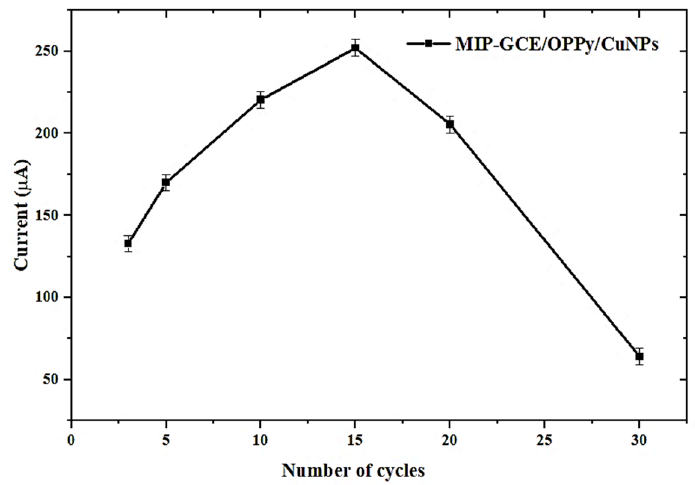
Figure 8. Effect of the number of electropolymerization cycles on the DPV peak current of sulfadiazine. Measuring conditions: 10 − 6 mol L − 1 SDZ in 0.1 mol L − 1 H 2 SO 4 (pH = 2).